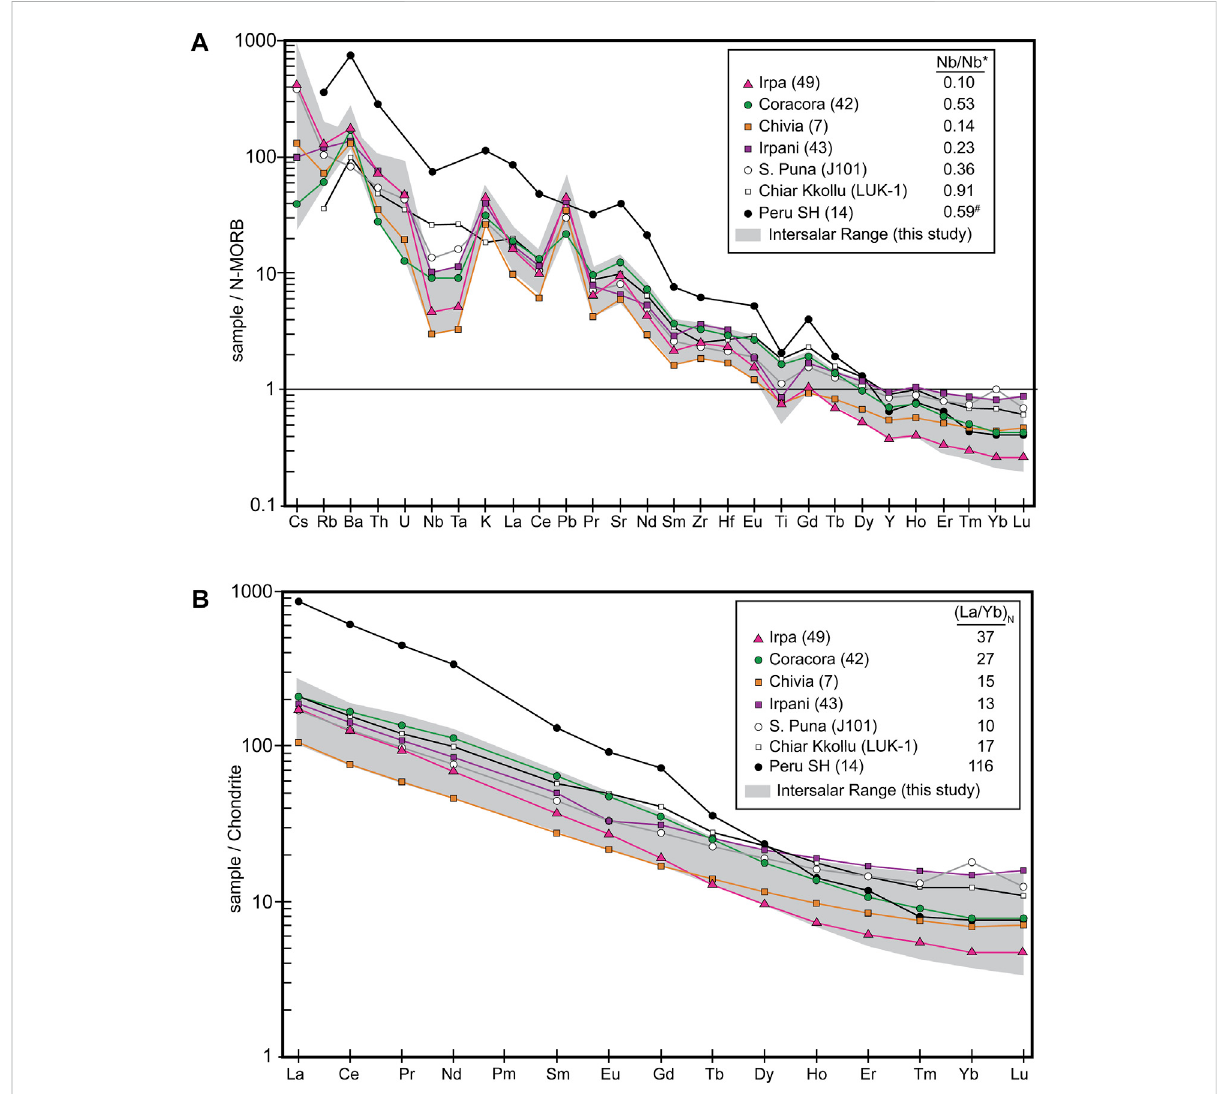
FIGURE 9 Normalizedabundances (Sunand McDonough, 1989)oftraceelements for representativeIntersalar Range samples:Plio-Pleistocene arc(Irpa) and reararc (Coracora); Miocene arc (Chivia) and reararc (Irpani). Prominent reararc lavas shown for reference and discussed in text (references as in Figure 7). Sample numbers in parentheses. (A) Spidergram showing incompatible element enrichment patterns relative to the primitive mantle. Notice the wide range in Nb and Ta values. The depth of the negative Nb anomaly shown as values of Nb/Nb*, calculated relative to U and K (#note that Peru shoshonites were not analyzed for U and the value of Nb/Nb* is calculated based on the curve of the pattern shown on this graph). Reararc lavas of both Plio-Pleistocene and Miocene lavas are characterized by smaller negative Nb anomalies (higher Nb/Nb* values) compared to the arc. (B) Chondrite-normalized REE patterns. In contrast to Nb/Nb*, the most pronounced differences in REE patterns correlate with age: Pliocene-Pleistocene samples (e.g., Irpa and Coracora) are characterized by steeper slopes and higher La/Yb ratios compared to the Miocene samples (e.g., Chivia and